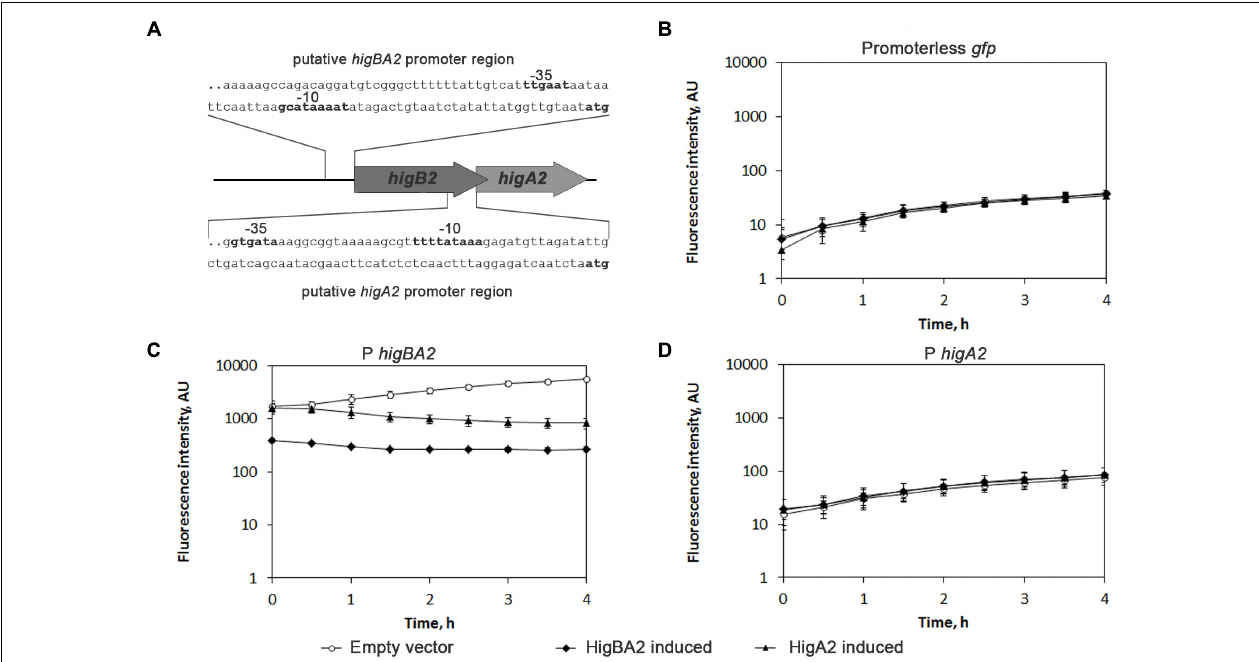
FIGURE 4 | Analysis of HigBA2 Ab interaction with own promoter region. (A) Schematic representation of A. baumannii higBA2 Ab locus. A part of pAB120 plasmid containing higBA2 Ab operon with predicted promoter is presented (not to scale). Predicted promoter DNA sequences (100 bp out of 200 bp cloned to vectors) used for promoter activity assay are shown, predicted –35 and –10 regions (BPROM) and ATG are indicated in bold; (B–D) The assessment of activity of predicted higBA2 Ab operon promoters. Predicted promoter regions of higBA2 Ab operon and higA2 Ab gene were cloned into pPROBE vector, placing them upstream the gfp gene as described in Section “Materials and Methods”. Then pPROBE with respective promoter sequence or lacking any promoter (Promoterless gfp ) was co-transformed into E. coli DJ624 (cid:49) ara harboring pBAD24 plasmids, with cloned higBA2 Ab operon or higA Ab antitoxin genes under arabinose inducible promoter. After addition of 0.2% arabinose, GFP fluorescence was measured every 30 min, reflecting the effect of induced proteins on the activity of measured promoters. Three independent experiments were performed, error bars indicate standard deviation. AU, arbitrary